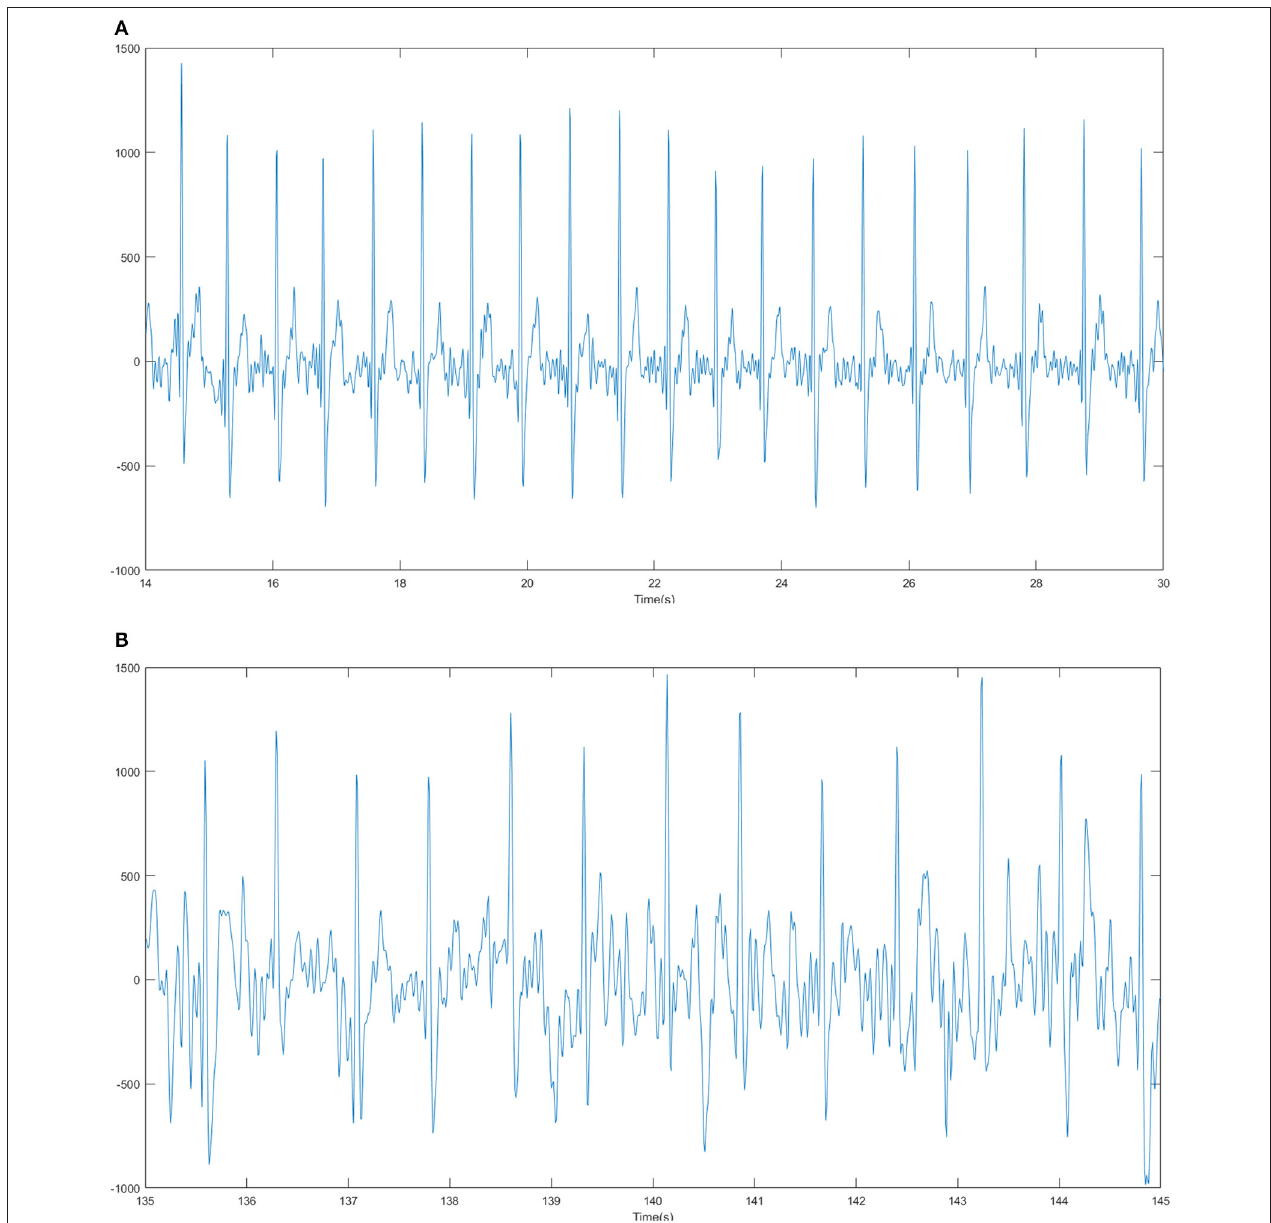
FIGURE 7 | The ECG waveforms of a subject during driving (A) in a straight section of the road and (B) turning along a large radius curve.